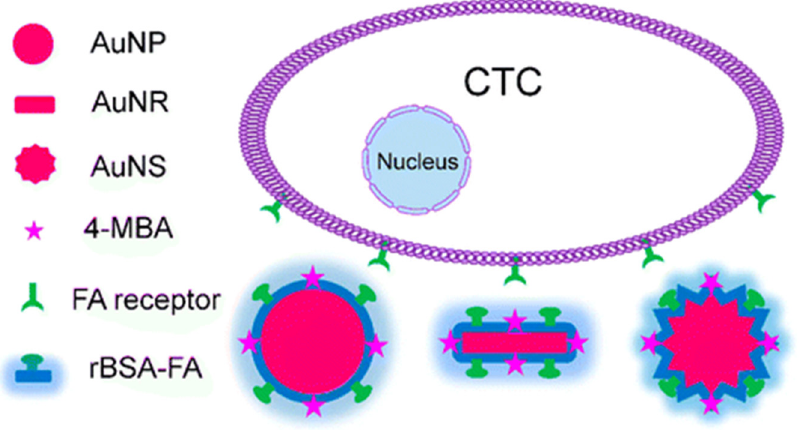
Figure 2. SERS-active NPs of various shapes used in CTC detection: spherical gold nanoparticles (AuNPs), gold nanorods (AuNRs), and gold nanostars (AuNSs). These NPs possess a strong SERS signal due to the modification of 4-mercaptobenzoic acid (4-MBA), which is the Raman reporter molecule. rBSA: reductive bovine serum albumin, which reduces nonspecific catching or uptake by healthy cells in the blood. FA: folic acid, targeted ligand. Reproduced with permission from [33]. Copyright 2016, American Chemical Society.